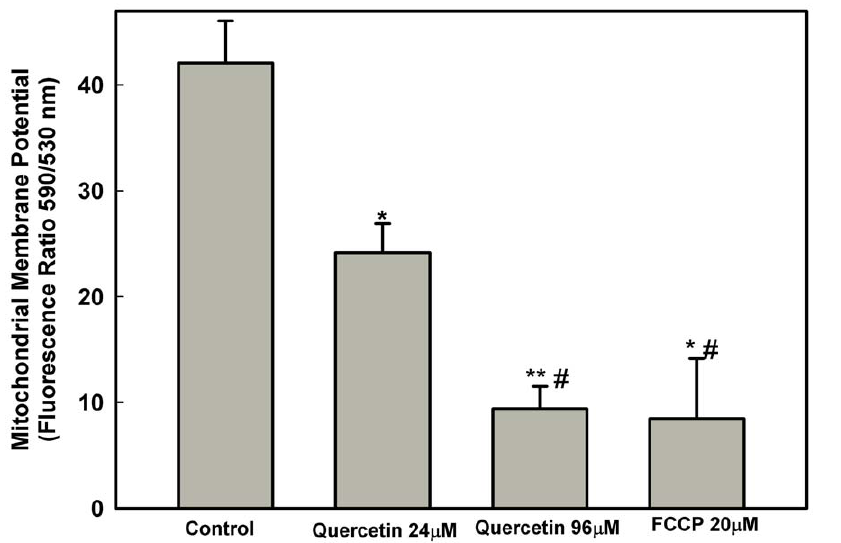
Figure 3. Effect of treatment of quercetin on the mitochondrial membrane potential of Leishmaniaamazonensis promastigote. Leishmania amazonensis was cultivated in Schneider’s Drosophila medium at 26 u C as for 48 h, in the absence or presence of 24 m M or 96 m M quercetin. Promastigotes were labeled with potentiometric probe JC-1 (10 m g/ml). Positive control was obtained by addition of FCCP (20 m M) for 20 minutes. In the control (absence of quercetin), the same volume of vehicle (DMSO 0.2%) was added to the growth medium. Dose-dependent changes in relative DY m values are expressed as the ratio of the fluorescence measurement carried out at 590 nm (for J-aggregate) versus 530 nm (for J-monomer). Data are expressed as means 6 standard errors of three different experiments. * indicates significant difference relative to the control group ( p , 0.05); ** indicates significant difference relative to the control group ( p , 0.01); # indicates significant difference relative to the 24 m M quercetin treated group ( p ,